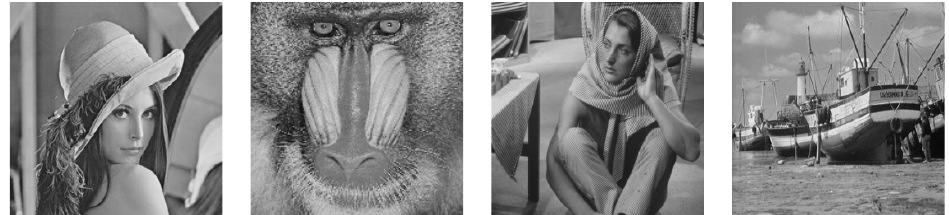
Figure 4. Original image of test images (Lena, Baboon, Barbara, and Boat).